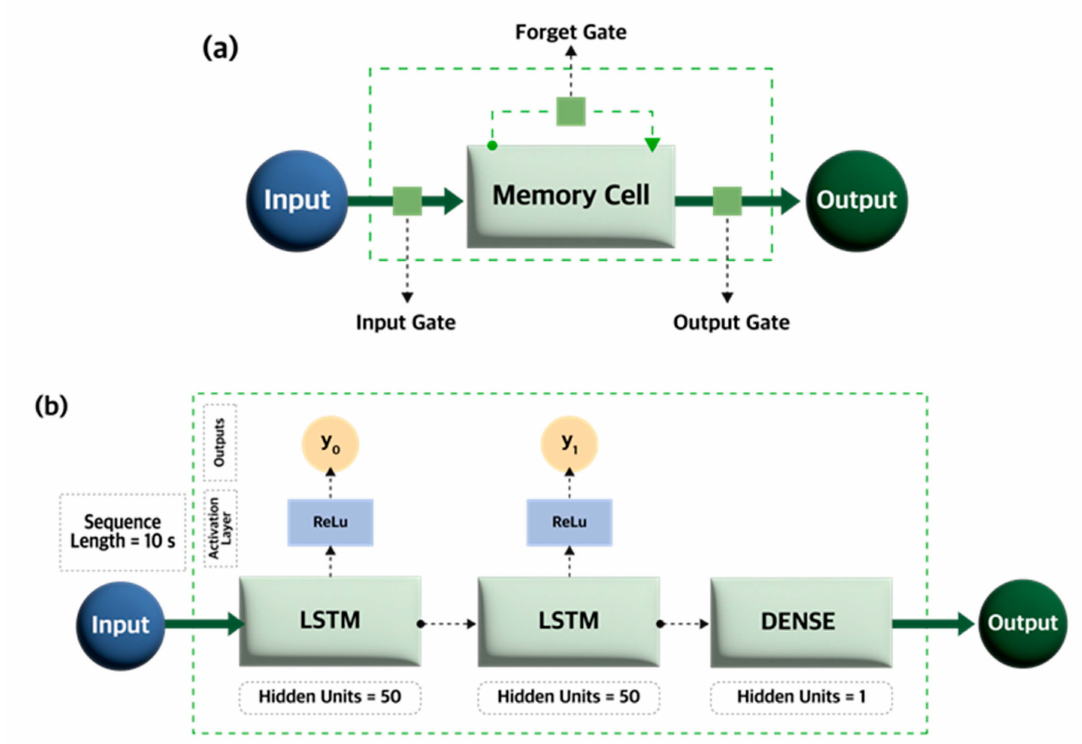
Figure 3. The prediction model architecture: ( a ) LSTM internal structure and ( b ) deep